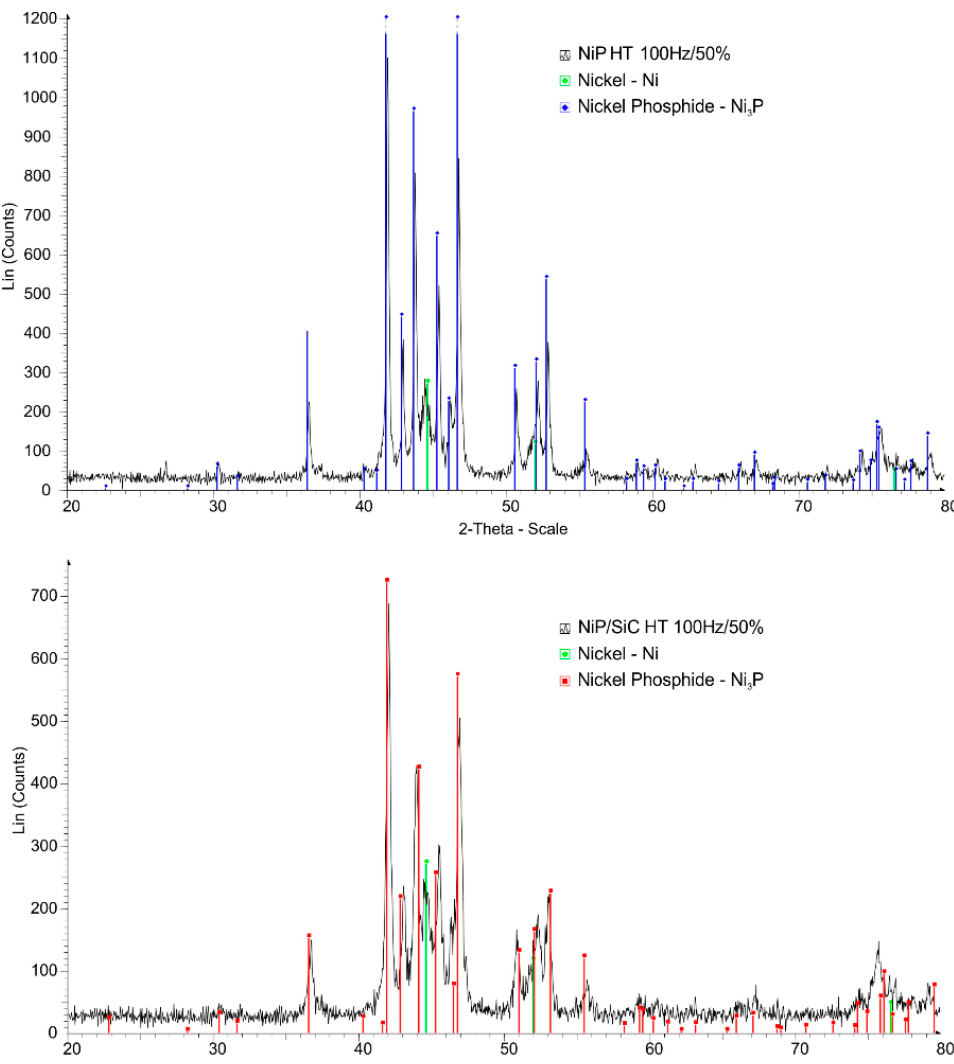
Figure 4. XRD spectra of the plain and SiC reinforced coatings developed at 50% duty cycle at 100 Hz after heat treatment.